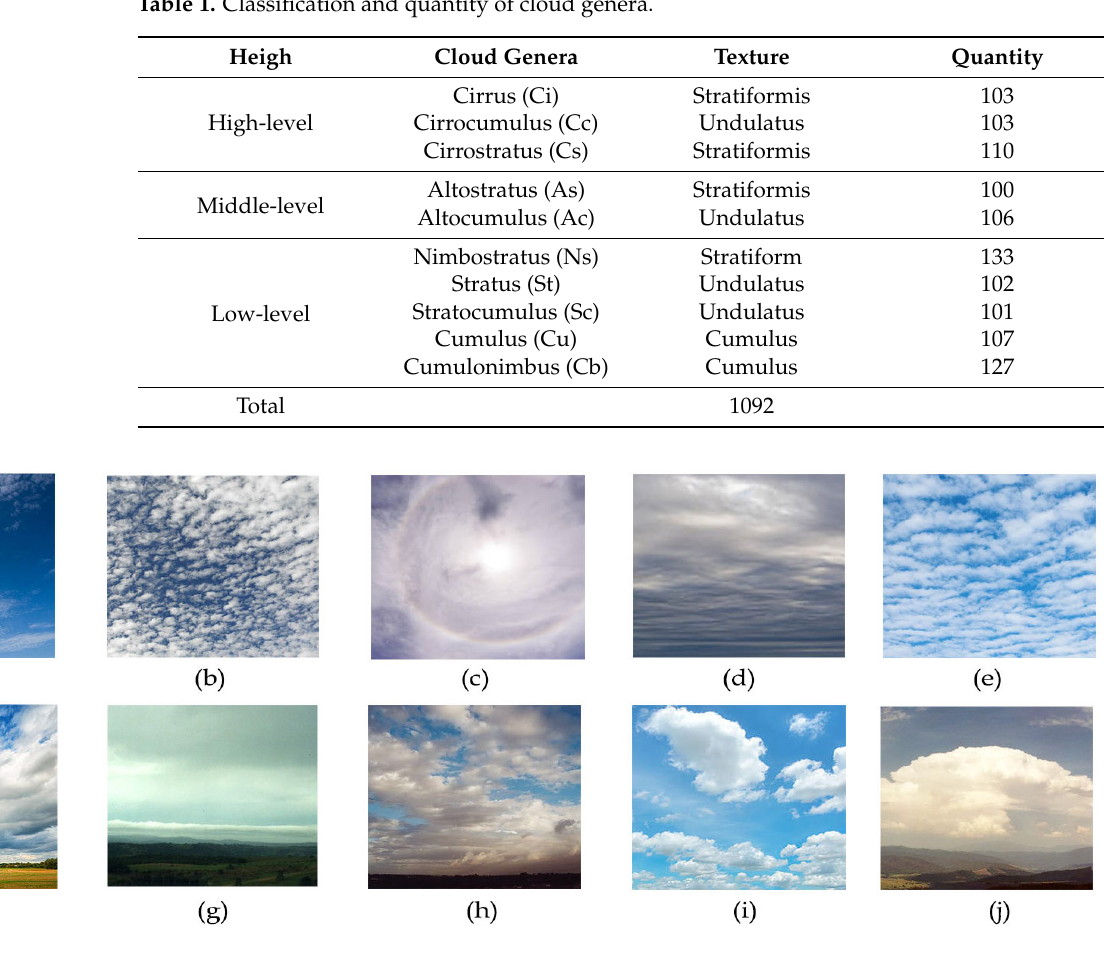
Figure 2. Display of the samples of each category in the SSC dataset. ( a ) Ci; ( b ) Cc; ( c ) Cs; ( d ) As; ( e